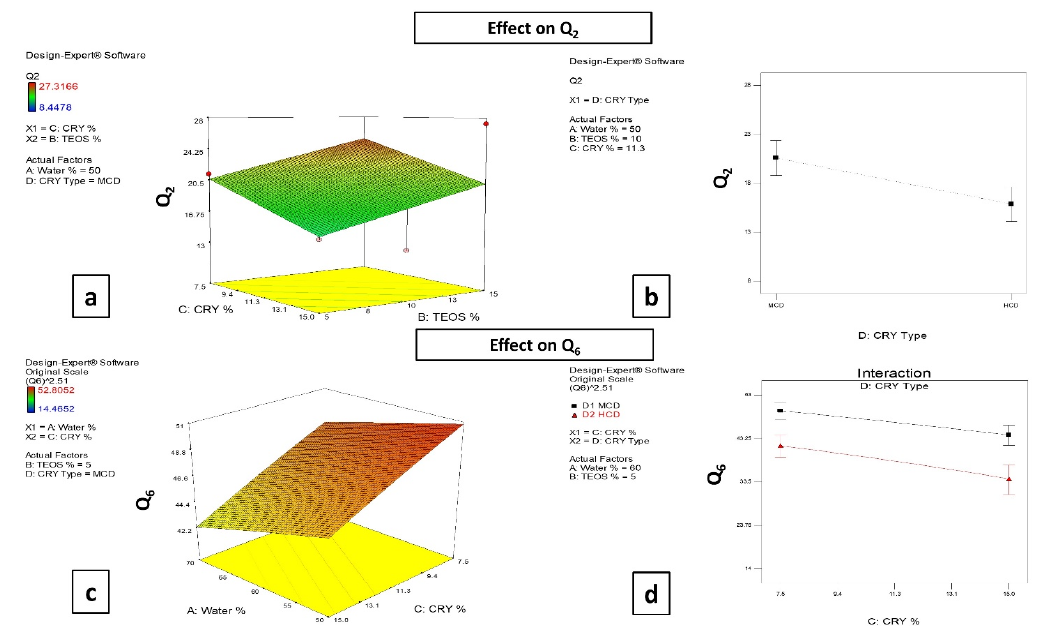
Figure 2. Response surface plots showing the effect of: TEOS percentage (TEOS %) and cryoprotectant percentage (CRY %) on Q 2 (a) and effect of cryoprotectant type (CRY Type) on Q 2 (b). The effect of aqueous phase percentage (Water %) and cryoprotectant percentage (CRY %) on Q 6 (c) and effect of cryoprotectant percentage (CRY %) and cryoprotectant type (CRY Type) on Q 6 (d).